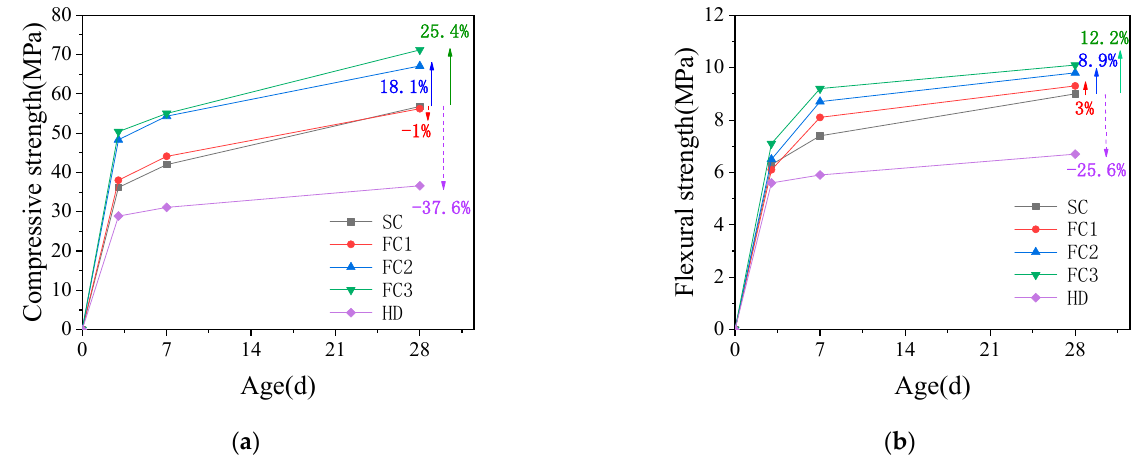
Figure 3. Strength of cement-fly ash mortar (FA25-M), ( a ) Compressive strength and ( b ) Flexural